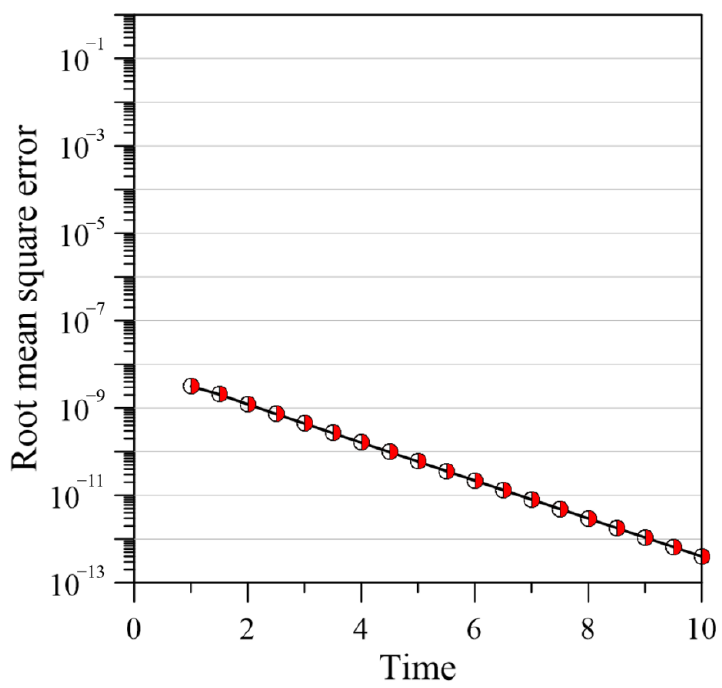
Figure 7. Plot of RMSE versus simulation time.